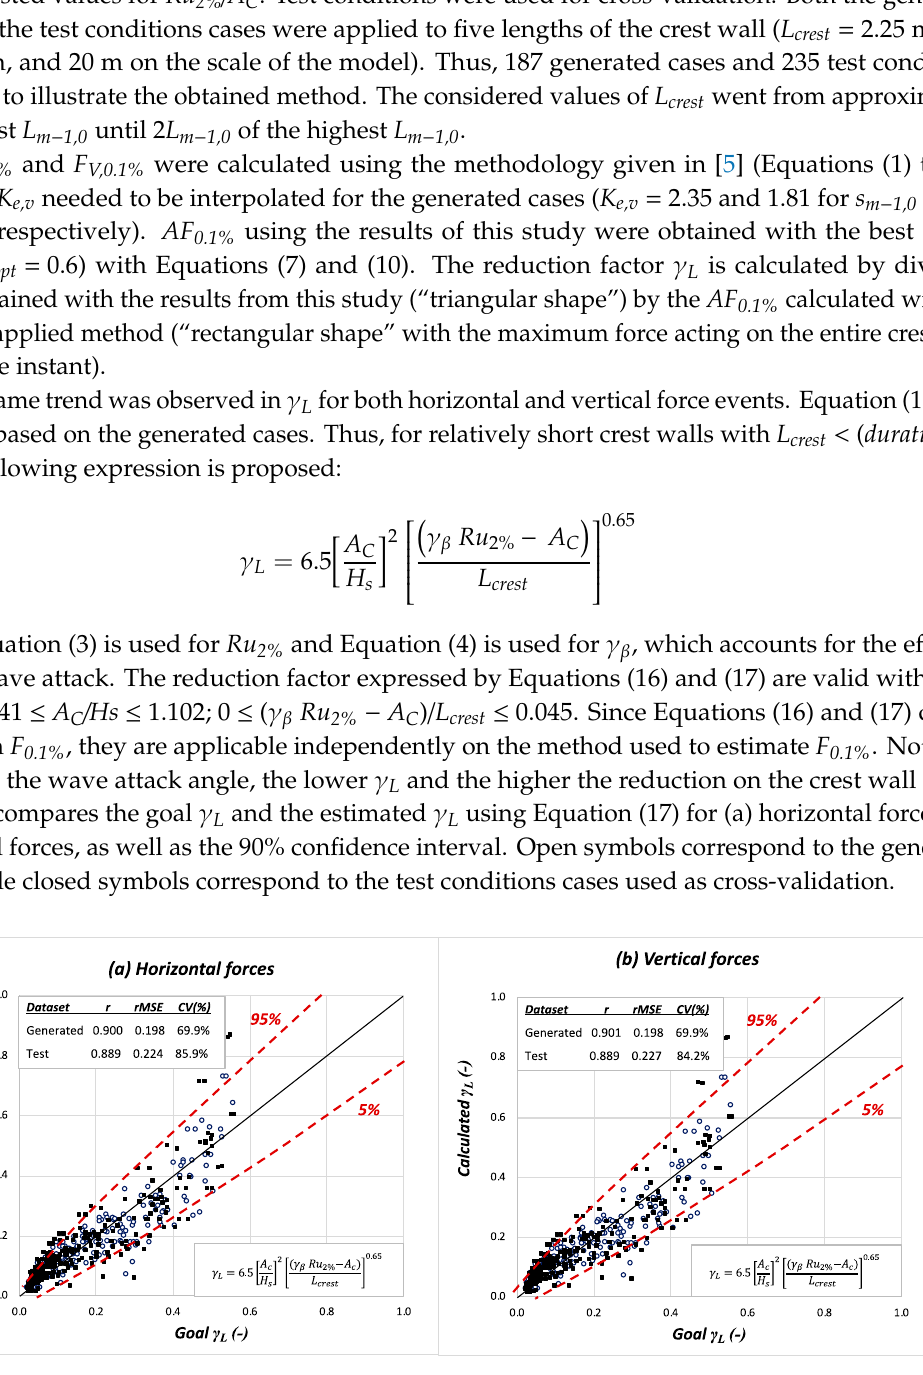
Figure 22. Comparison between the goal γ L and the estimated γ L with Equation (16), as well as the 90% confidence interval for ( a ) horizontal forces and ( b ) vertical forces. Generated cases correspond to open symbols, while test conditions correspond to closed